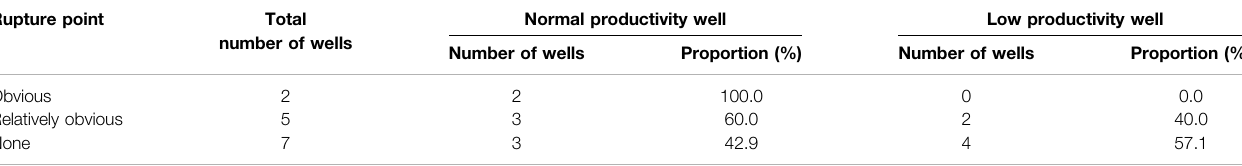
TABLE 2 | Statistical results of the obviousness of rupture points in fractured horizontal wells. Rupture